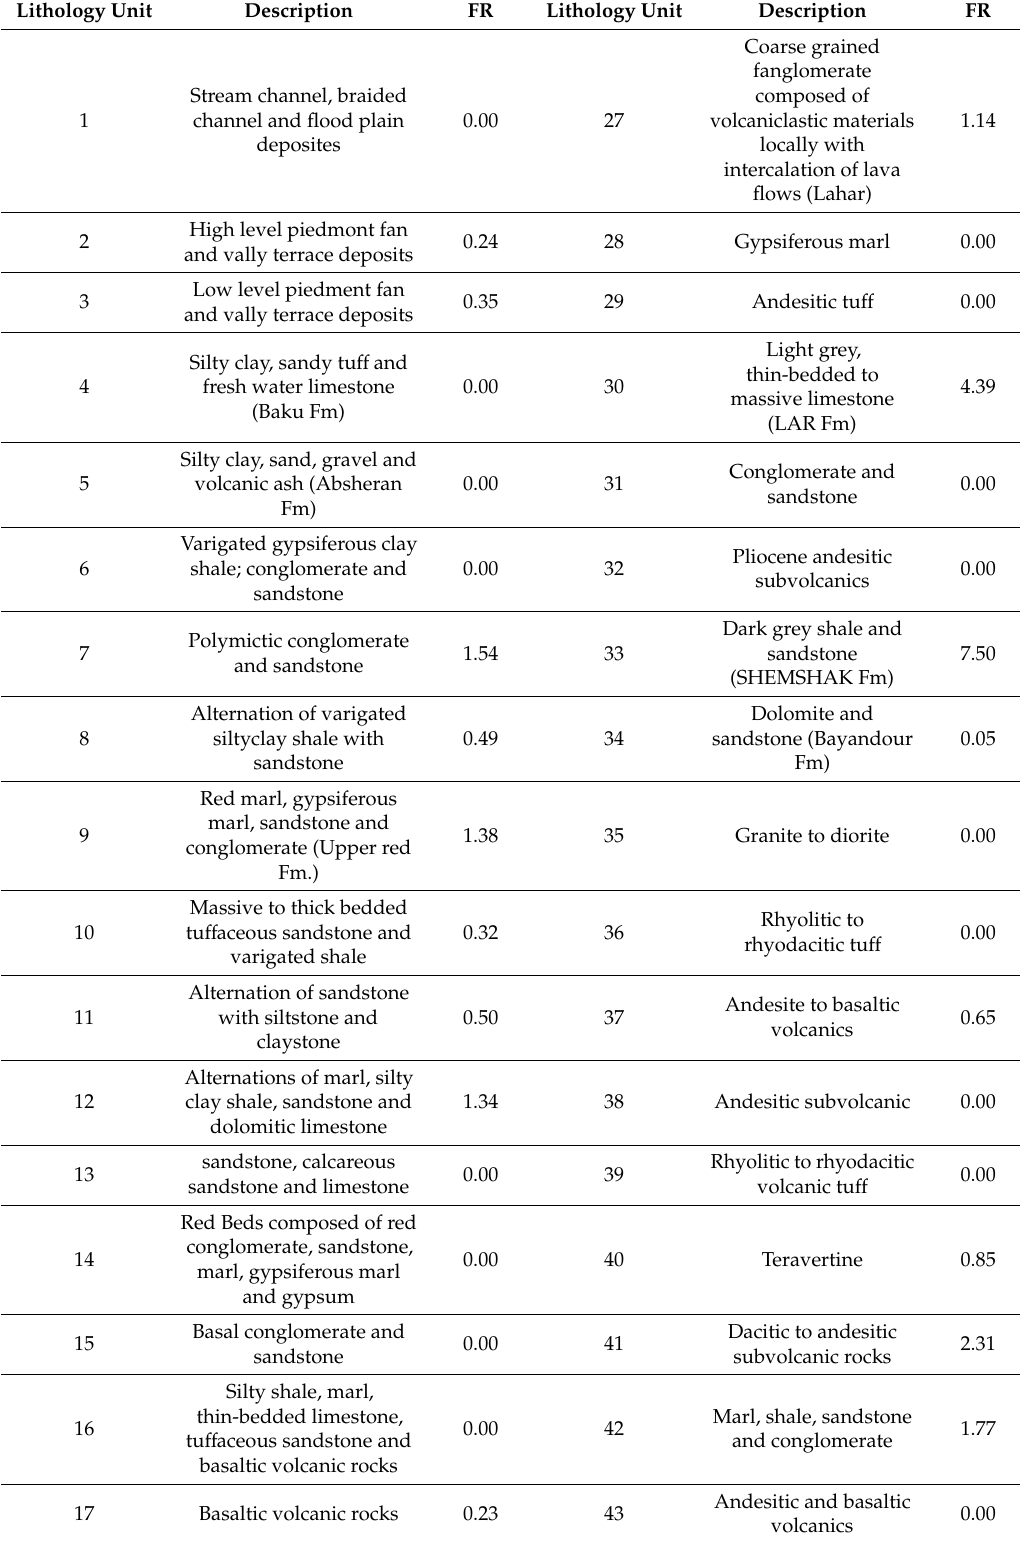
Table 1. Description of the lithological